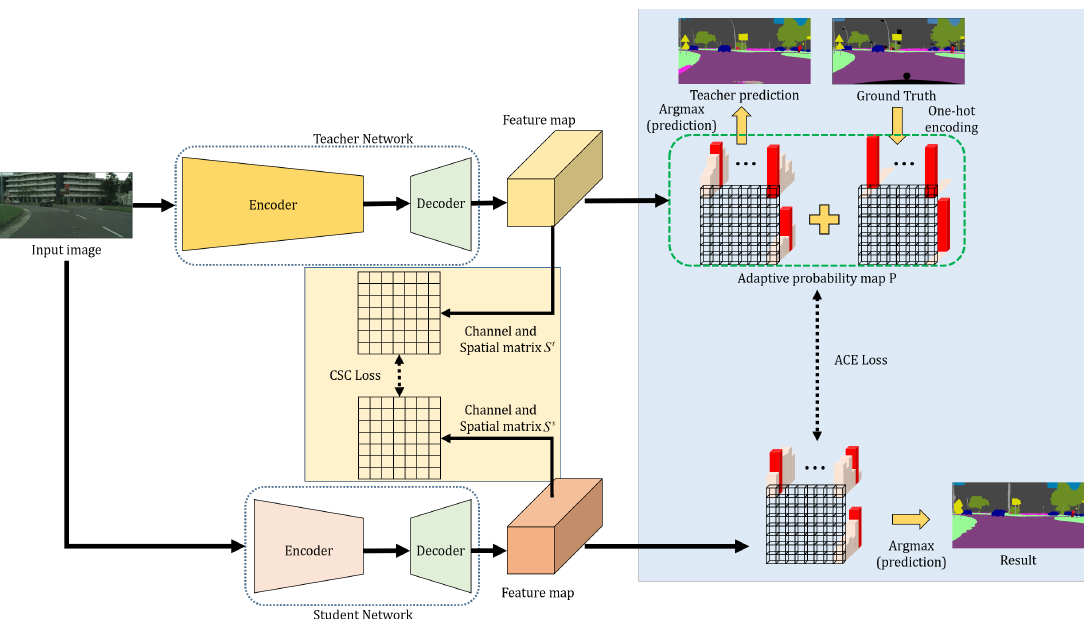
Figure 2. Framework of our proposed knowledge distillation method. Both the structures of the teacher and the student network have the same architecture, as Deeplab-V3 + [11], but different encoders. The depth of the encoder of the student network is shallower than that of the teacher network. Using the proposed CSC loss function, we can efficiently transfer the spatio-channel information of the teacher network to the student network. Using the proposed ACE loss function, the probability map result of the teacher network and ground-truth values can be adaptively transferred to the student